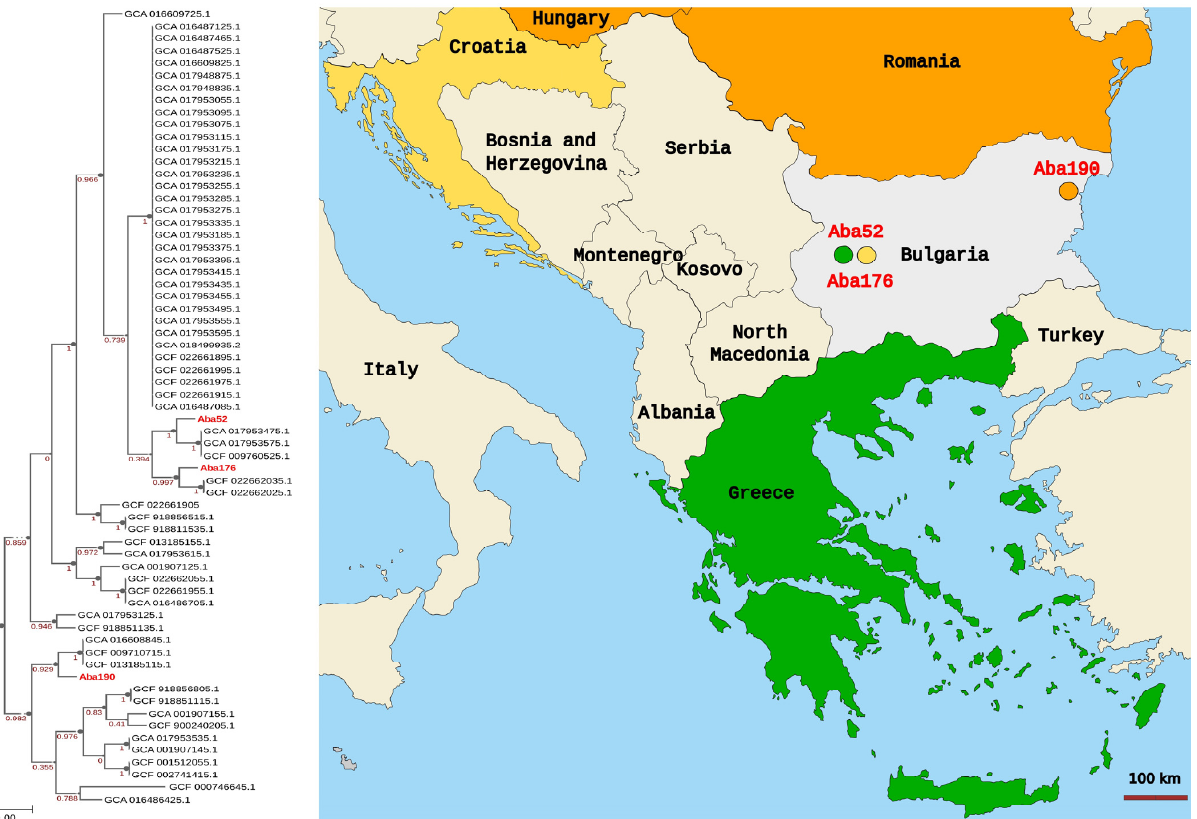
Figure 2. Phylogenetic tree constructed on 49 universal core gene multiple-sequence alignment of 66 colistin-susceptible A. baumannii clinical isolates from neighboring South-Eastern European countries. The countries of origin for the closest matches of the three isolates here were color-coded.